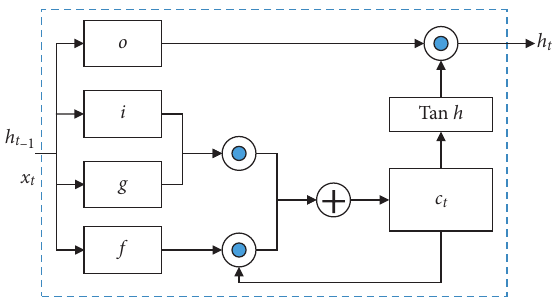
Figure 2: Structure of a typical LSTM